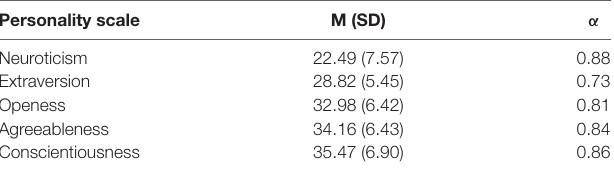
TABLE 2 | Descriptive statistics (Mean, SD) and internal consistency (cronbach’s alpha) for personality traits measured by NEO-Five Factor Inventory (NEO-FFI). Personality scale